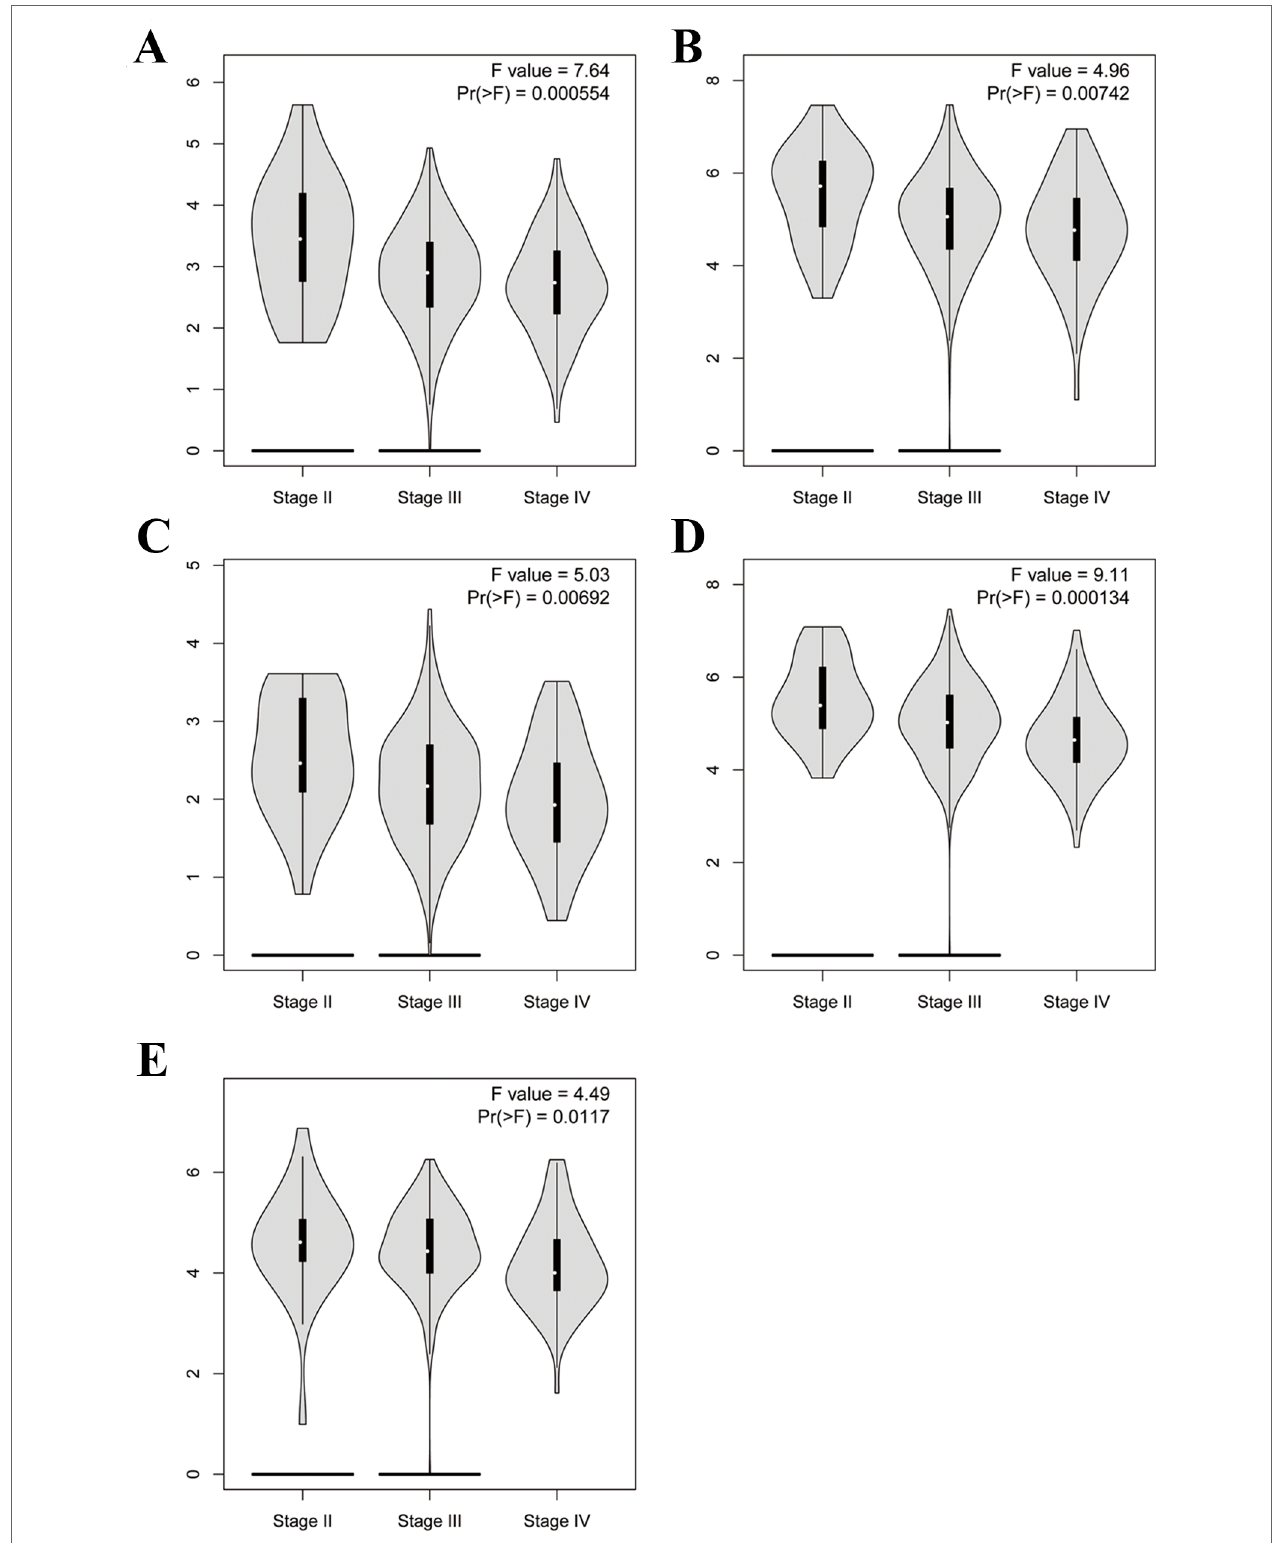
FIgUrE 12 | Violin plot showing five key genes expression in different major pathological stages of EOC. The y -axis represents log2 (TPM + 1). (A) CDCA5, (B) FOXM1, (C) KIF15, (D) MCM2, (E) ZWINT.